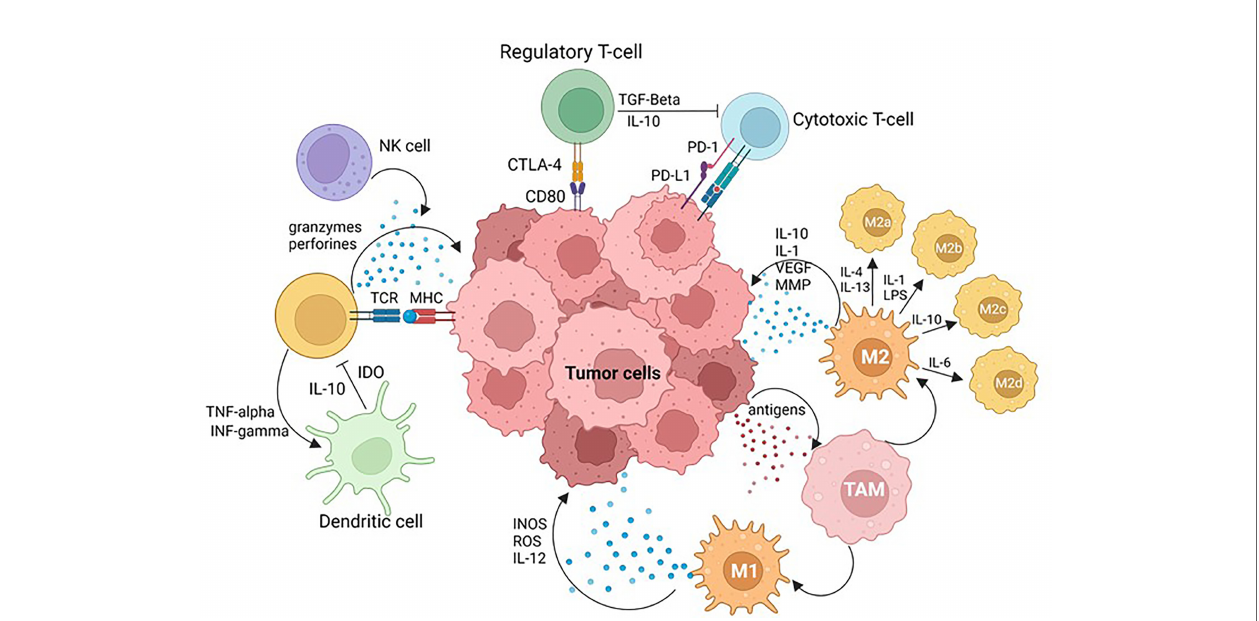
FIGURE 2 | Tumor Microenvironment (TME). PD-L1 tumoral cell expression and PD-1 immune cell axis plays a key role in physiological immune homeostasis and contributes to tumor cell immune evasion. Cytotoxic T-lymphocyte antigen 4 (CTLA-4) ligation to CD28 quantitatively augments TCR-mediated signals, as well as activating independent pathways to upregulate CD28-mediated cytokine production and proliferation, raising the threshold needed for T-cell activation and arresting T-cell-cycle progression. Simultaneous recognition of a speci fi c major histocompatibility complex (MHC) – peptide complex by the T-cell receptor (TCR) and of B7-1 (CD80) or B7-2 (CD86) also results in T-cell activation, cytokine production, proliferation and differentiation. Natural killer (NK) cells are effector lymphocytes that play protective roles against both infectious pathogens and cancer. Dendritic cells (DC) are professional antigen presenting cells, able to induce naïve T cell activation and effector differentiation, involved in the induction and maintenance of immune tolerance in homeostasis. Tumor associated macrophages (TAMs) are constituted by: M1 macrophages that play critical roles in innate host defense by producing reactive oxygen/nitrogen species (ROS/RNS) and pro-in fl ammatory cytokines such as IL-1 b , IL-6, tumor necrosis factor a (TNF- a ), and M2 macrophages that produce anti-in fl ammatory cytokines such as IL-10, IL-13 and TGF- b to promote tumor development. Image created with